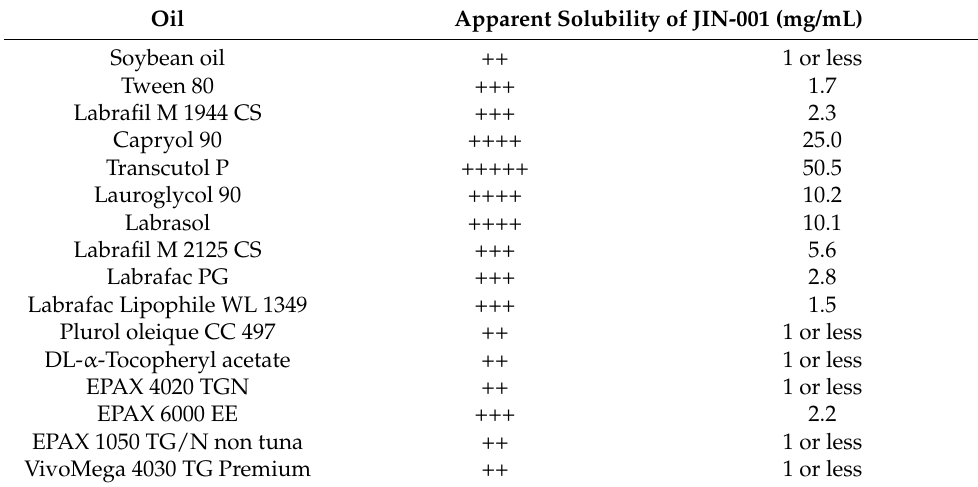
Table 3. The apparent solubility of JIN-001 in various